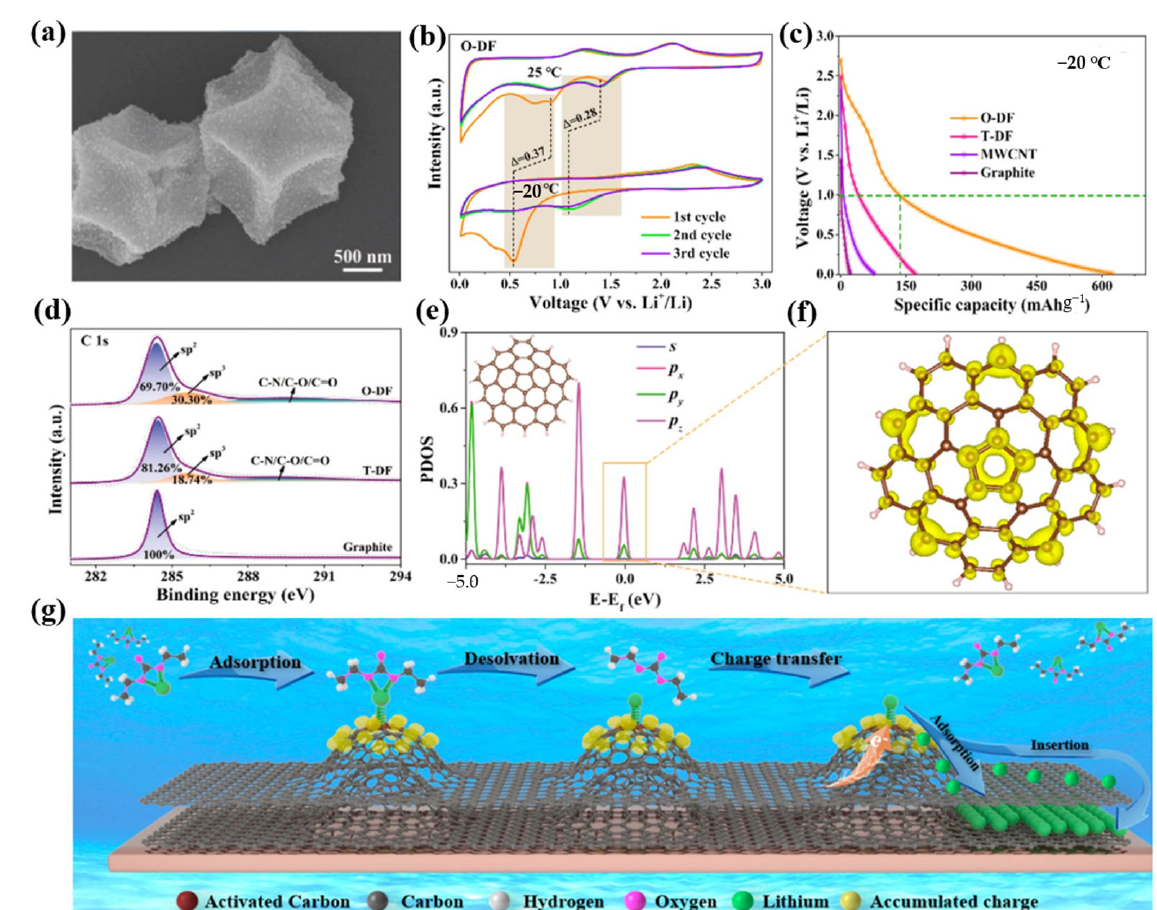
Figure 4. ( a ): SEM images of O ‐ DF. ( b ): CV curves of O ‐ DF for − 20°C at 0.1 mV s − 1 compared with the corresponding curves for room temperature. ( c ): Galvanostatic discharge curves of O ‐ DF, T ‐ DF, MWCNT, and graphite for − 20°C at 0.1 A g − 1 after 150 cycles. ( d ): High ‐ resolution XPS C 1s spectra of O ‐ DF, T ‐ DF, and graphite. ( e ): PDOS of C atoms for positive curvature structure. ( f ): Charge density distribution with isosurface values of 0.005 e/Å 3 corresponding to energy windows of positive curvature carbon in ( e ) near the Fermi level. The yellow represents electron accumulation. ( g ): Accumulated charges originate from the sp 2 /sp 3 ‐ hybridized orbital of the positive curvature structure for low ‐ temperature lithium storage. ( a – g ) Reproduced with permission from [94].